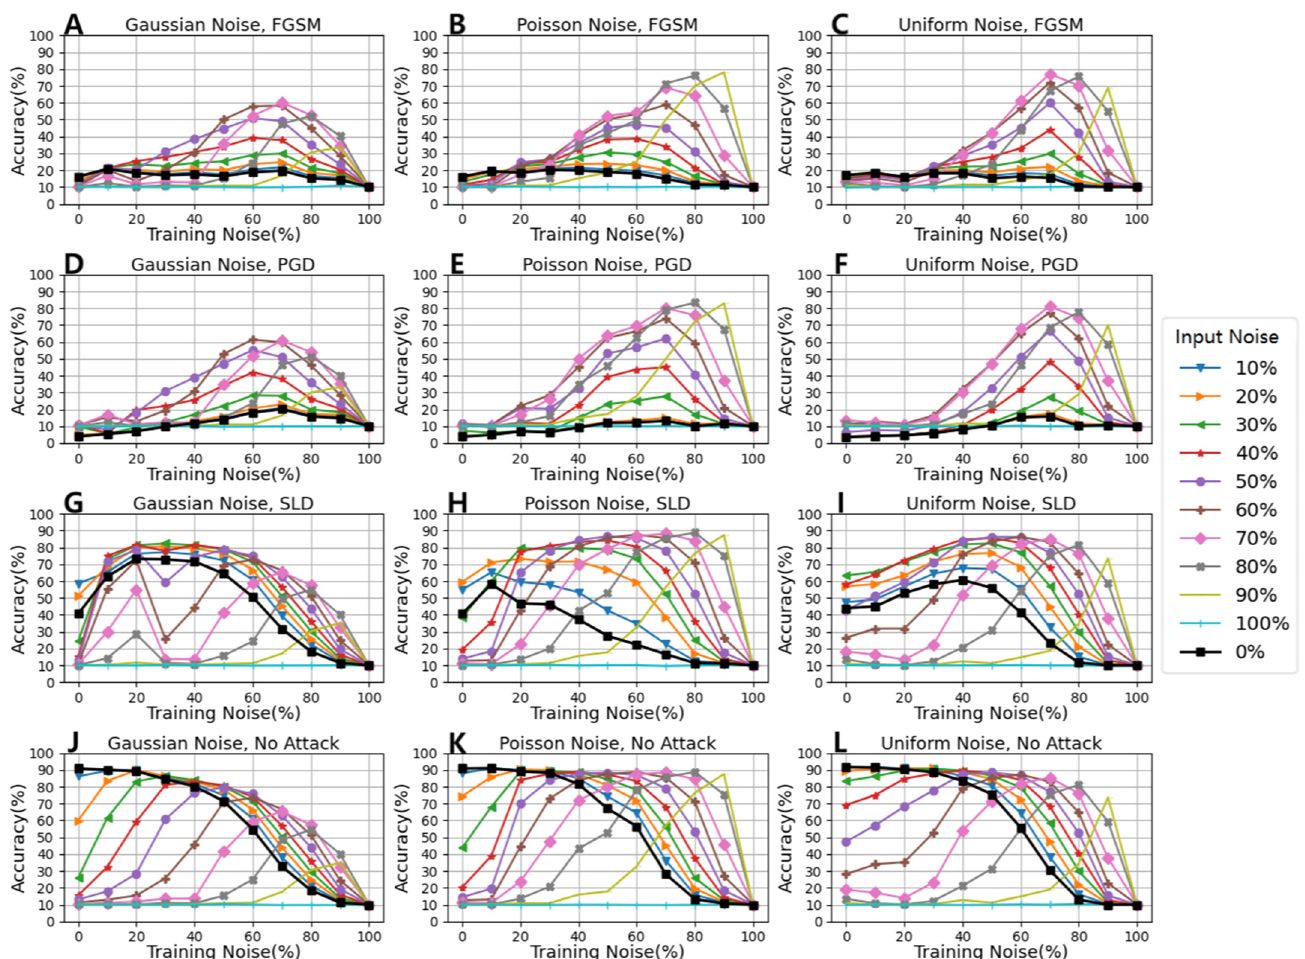
Figure 7. Accuracy of the CIFAR-10 at training dimension. The x axis is the training noise amplitude, and the y axis is the accuracy. Different color curves with various symbols indicated different amplitudes of input noise.